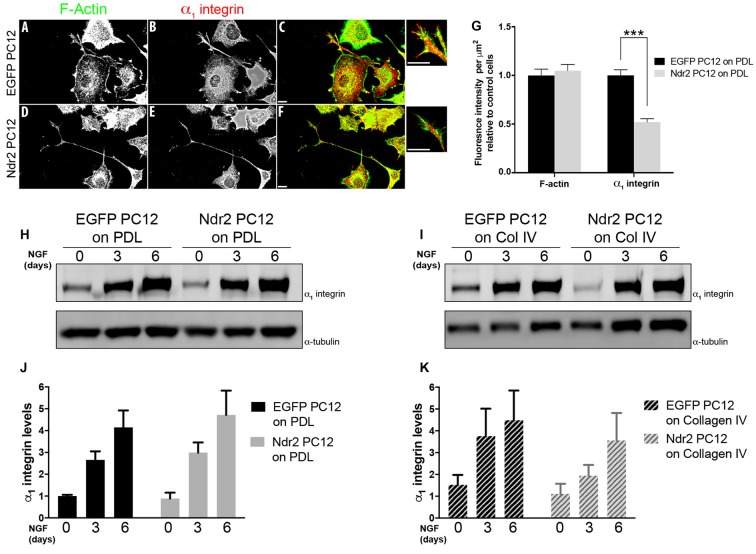
Reduced localization of α1 integrin to neurite tips. (A,B) Microscopic images of 6 day neurite growth factor (NGF) treated PC12 cells showing the expression and distribution F actin and of the α1 integrin receptor in control and (D,E) Ndr2 PC12 cells. (C,F) Overlay image. Scale bars: 10 μm. (G) Quantification of labeling at neurite tips (n = 46 for EGFP PC12, 49 for Ndr2 PC12 cells) reveals a significant reduction of α1 integrin levels in Ndr2 PC12 cells compared to EGFP PC12 cells (two-tailed Student’s t-test, p < 0.001), but no change in F-actin (two-tailed Student’s t-test, p = 0.595). (H,I) Immunoblotting shows the elevated expression of α1 integrin in both cell lines upon 3 days or 6 days of NGF treatment on both substrates. (J,K) Quantification of the blots shows that α1 integrin protein levels increases similarly during differentiation in EGFP PC12 and Ndr2 PC12 cells (n = 4 each; on PDL: two-way ANOVA, genotype effect: F(1,18)= 0.2754, p = 0.6062; on Collagen IV: two-way ANOVA, genotype effect: F(1,18)= 1.74, p = 0.2036). Values are mean + SEM; ***p < 0.001.